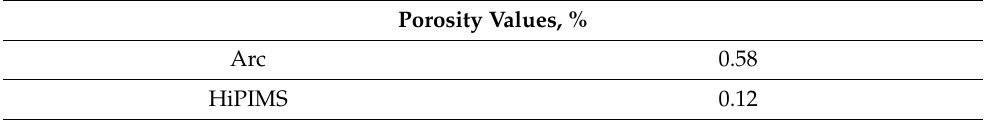
Table 2. Porosity values of the studied